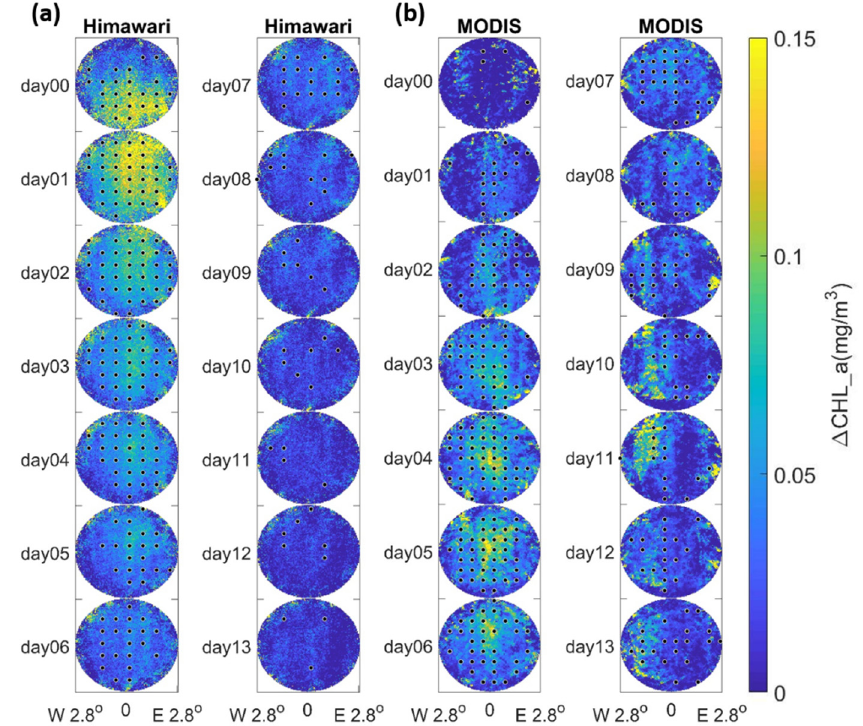
Figure 6. Continuous progression of the spatial characteristics of TICRs processed and calculated from △𝐶𝐻 ( 𝑖 , 𝑗 ) of (a) AHI/Himawari-8 and (b) MODIS responding to typhoon passages in different stages. Dots denote the areas with values that are statistically significant, satisfying the two-tailed t-test at 95% confidence level.